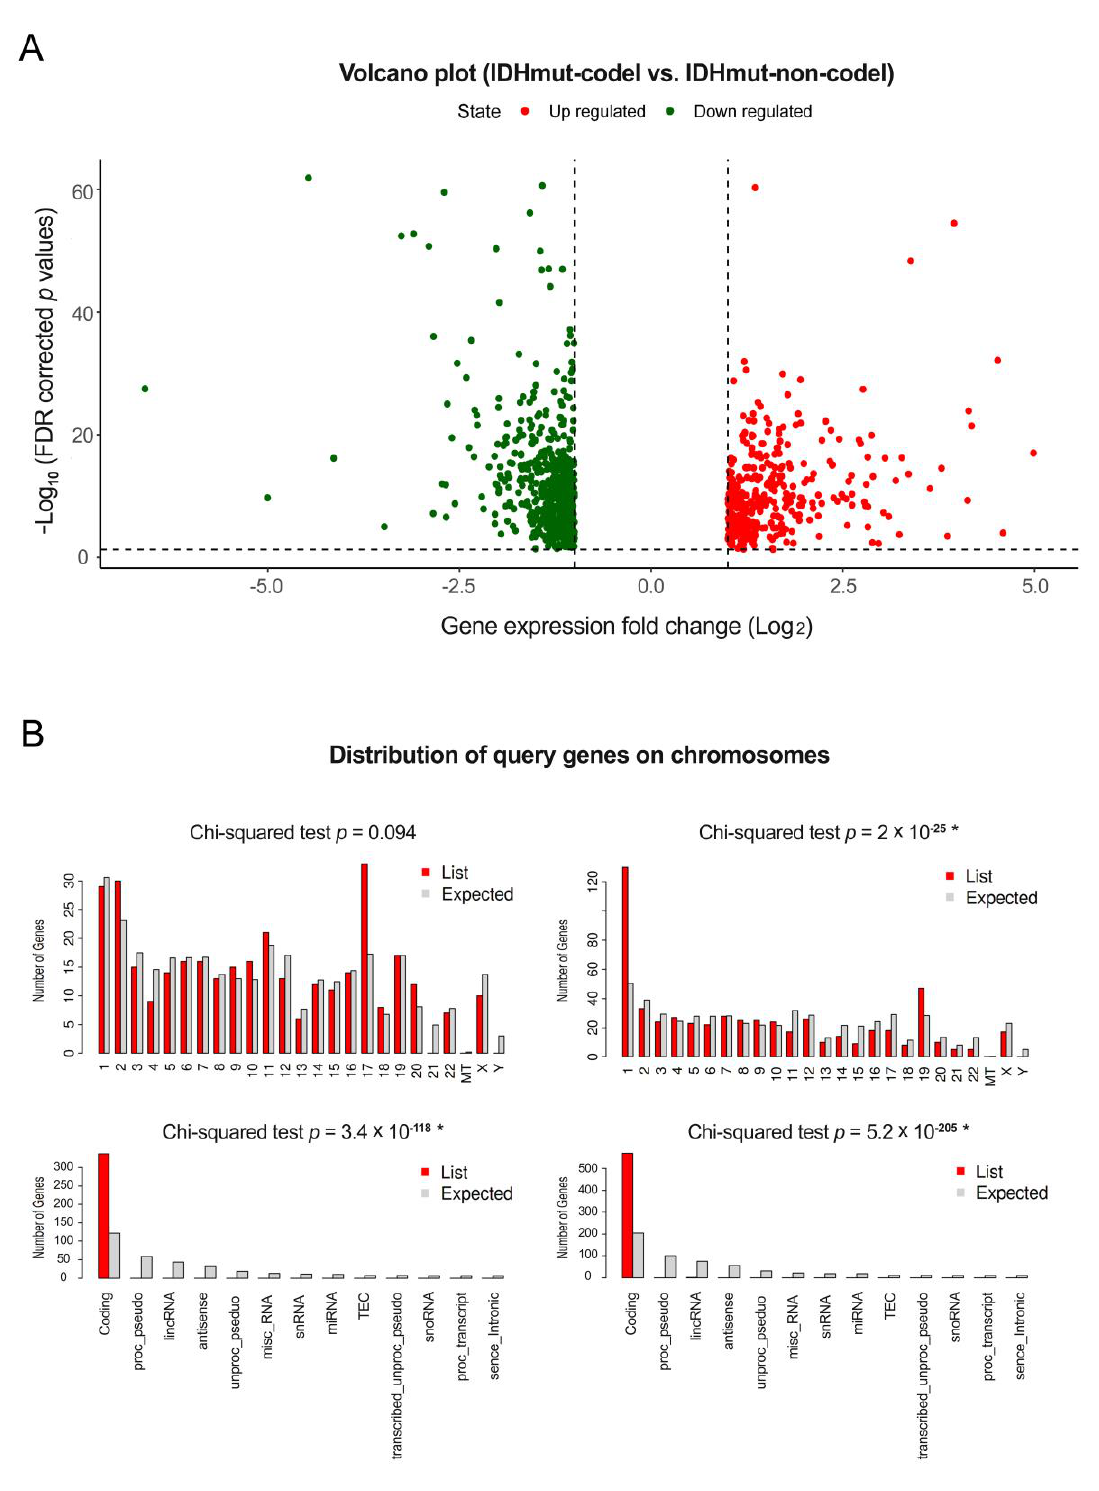
Figure 1. Volcano plots and distribution of genes on chromosomes for DEcodingRNAs between the OD 1p / 19q codeletion group and the non-codeletion group. The volcano plot of DEcodingRNAs. The red dots represent significantly upregulated genes, the green dots represent significantly downregulated genes ( | log2 FC | ≥ 1 and FDR < 0.05) ( A ). Histogram of input gene sets and distribution on chromosomes for upregulated DEcodingRNAs (left) and downregulated DEcodingRNAs (right) ( B ). * indicates significant p